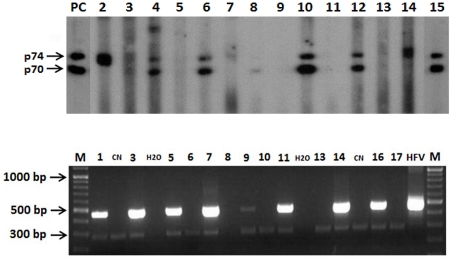
Serological and molecular results patterns for SFV detection.A) Western blot results using purified classical chimpanzee antigen sero-positive samples (lanes 3, 4, 6, 10, 12). Sero-indeterminate (lanes 2, 7, 8, 14). Sero-negative samples (lanes 5, 9, 11, 13). Positive SFV control serum from a gorilla-infected human (lane 15), and a macaque (lane PC). B) Nested PCR detection of 465 bp Integrase sequences of SFV M = molecular weight marker. CN = Negative Control. HFV = Human foamy virus, positive control, H2O = Water.